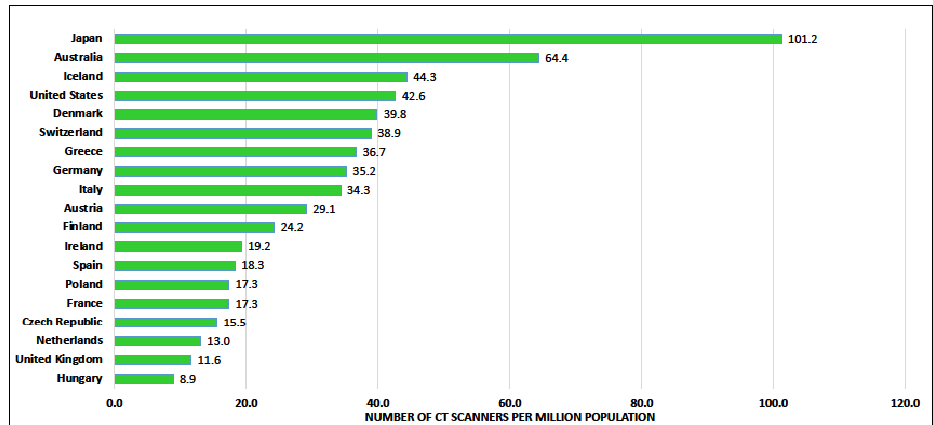
Figure 2. Number of CT scanners per million inhabitants.